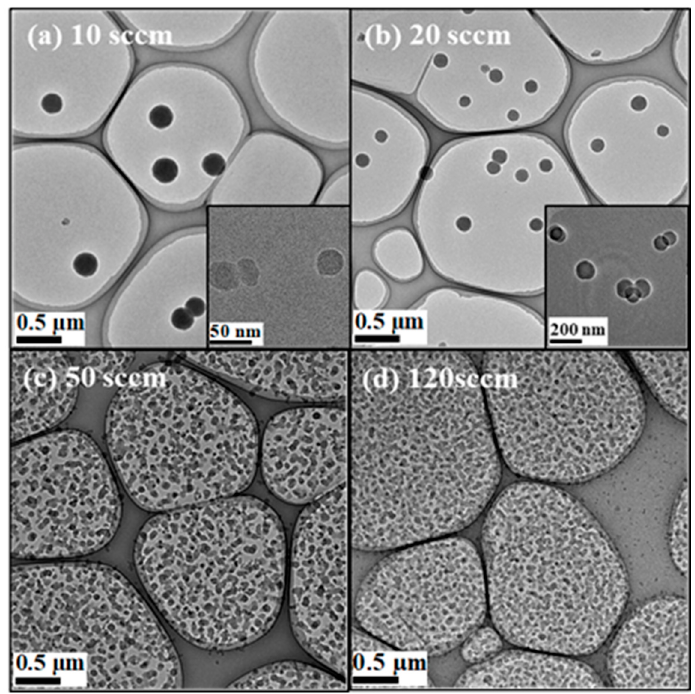
Figure 2. TEM images of carbon nanoparticles produced for ( a ) FR = 10 sccm, ( b ) FR = 20 sccm, ( c ) FR = 50 sccm, and ( d ) FR = 120 sccm. Insets in ( a ) and ( b ) show their high magnification TEM images.